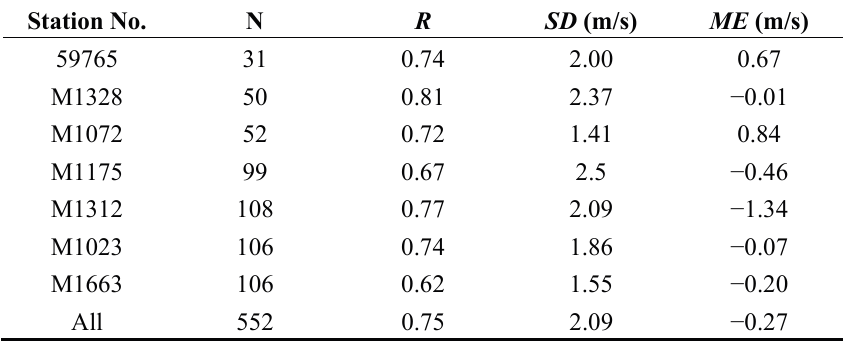
Table 5. Statistic results for wind speed between in situ data vs. SAR-wind. N is the number of comparing samples, R is the correlation coefficient, SD is the standard deviation (m/s); ME is the mean error (m/s).